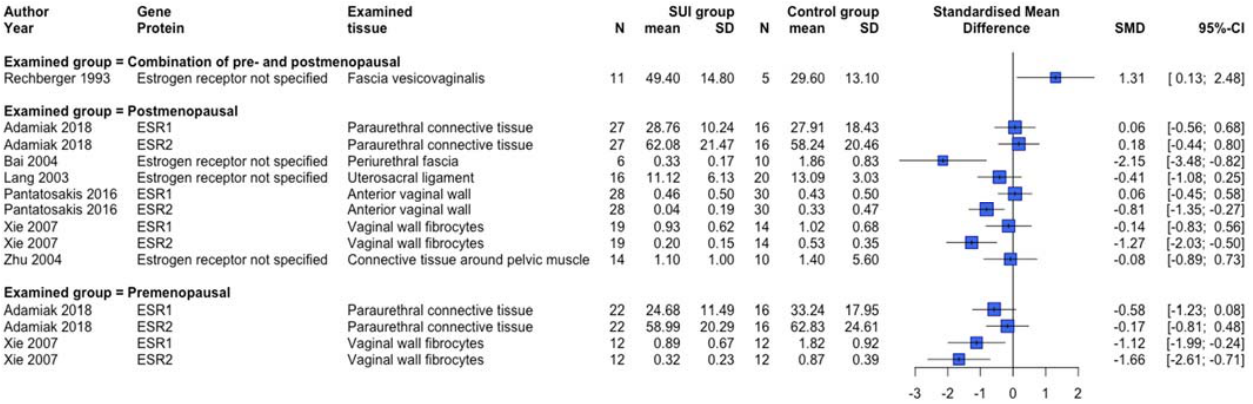
Figure 6. Forest plot of estrogen receptor-related protein expression in human studies. This forest plot shows estrogen receptor-related protein expression differences between patients with SUI and controls, subdivided per menopausal status group. Abbreviations: CI confidence interval, N number, SD standard deviation, SMD standardized mean difference, SUI stress urinary incontinence.